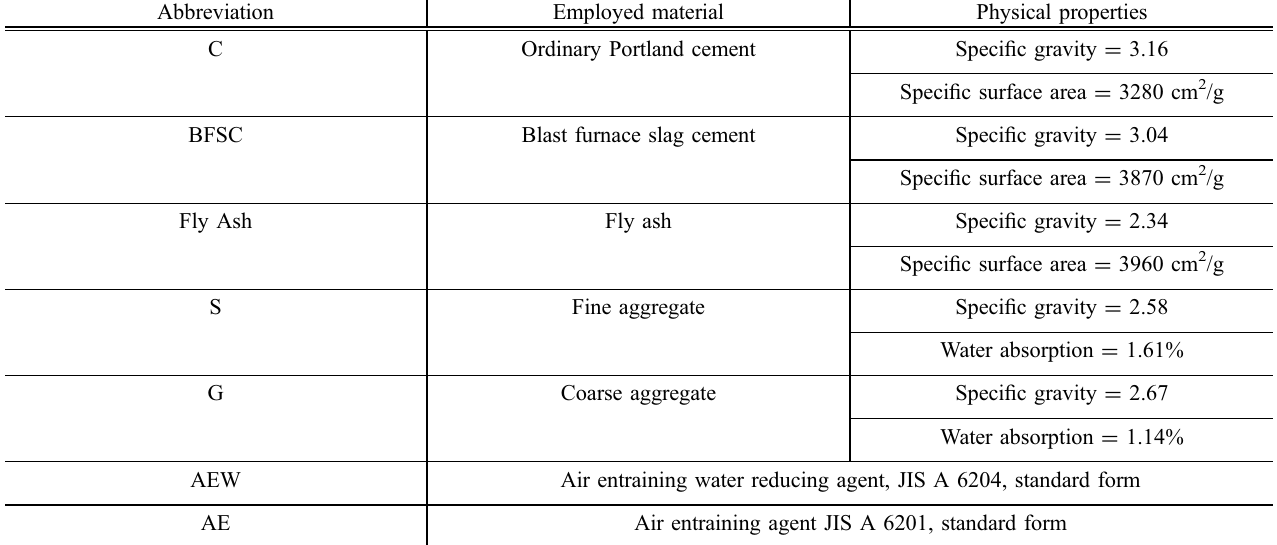
Table 1 Physical properties of materials used.